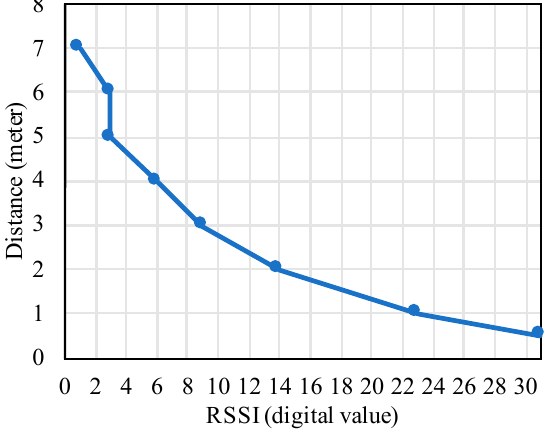
Figure 7. Received signal strength indicator (RSSI) of the receiver at different distances from the transmitter.